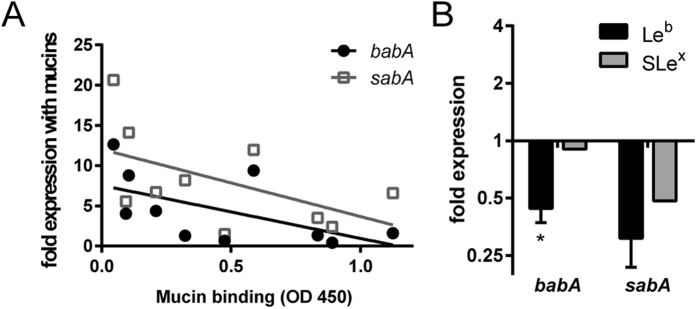
Expression of babA and sabA in response to mucins and ligand binding.(A) Correlation between mucin binding of J99 wt (as analyzed by microtiter based assay) to 10 different (individual) human mucin samples and gene expression of babA (p = 0.068, r = −0.597) and sabA (p = 0.085, r = −0.571, Pearson correlation) in J99 wt after 24 h culture with these mucins. 9 of the 10 mucins were positive for Leb 21. (B) Expression of babA and sabA in H. pylori J99 after 24 h culture with Leb- and SLex-glycoconjugates. Stars indicate change of expression compared to untreated bacteria confirmed by paired sample t-test, where Ct values of each experiment were paired to remove confounding factors of variable base levels between experiments. Fold expression compared to bacteria cultured without glycoconjugates or mucins are shown where expression is calculated as ΔCt in relation to expression of 16S rRNA as a housekeeping gene. Values are mean ± S.E.M. from 2 biological replicates, where each data point consists of the mean of 2 technical replicates with very similar result, *p ≤ 0.05.